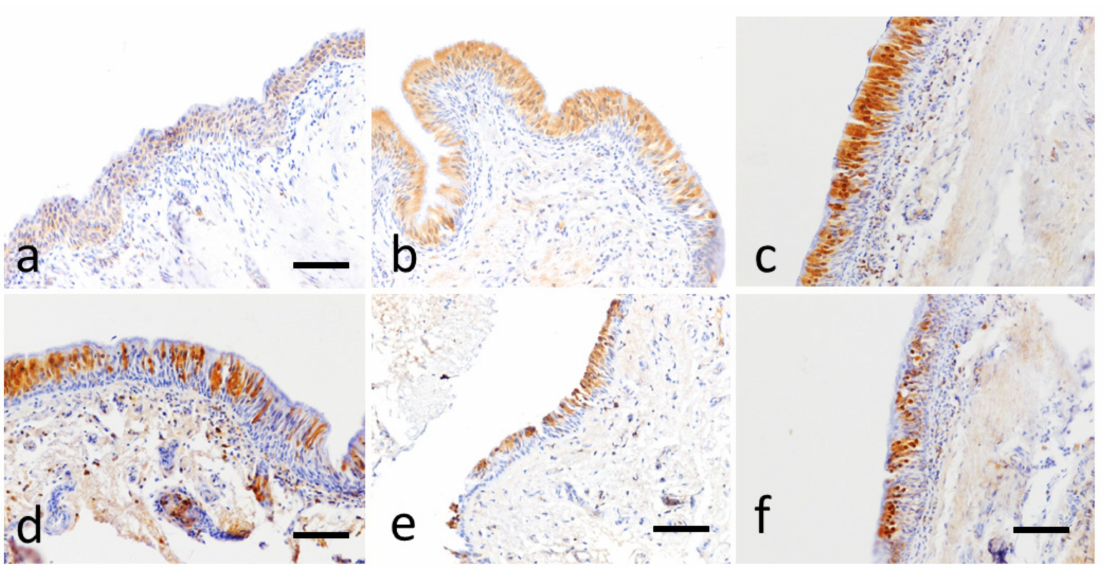
Figure 4. NKA immunohistochemical stain (brown color), bar 200 µ m. ( a ) Bronchial mucosa of a control horse. Weak and diffuse cytoplasmic positivity of the respiratory epithelium. ( b ) EA-case 3, distal right bronchus, T2. Moderate and diffuse cytoplasmic positivity to the epithelial cells of the respiratory mucosa, associated with an intense nuclear positivity. ( c ) EA-case 1 horse, proximal right bronchus, T3. Intense, diffuse, cytoplasmic and nuclear positivity, mainly localized in the more superficial layers of the hyperplastic respiratory epithelium. ( d ) EA-case 3 horse, distal right bronchus, T3. Intense, diffuse cytoplasmic and nuclear localized mainly in the superficial layers of the epithelium. ( e ) EA-affected 6, proximal left bronchus, T1. Positivity confined to the luminal layer of the epithelium. ( f ) EA-case 2, distal left bronchus, T3. Predominantly nuclear positivity.